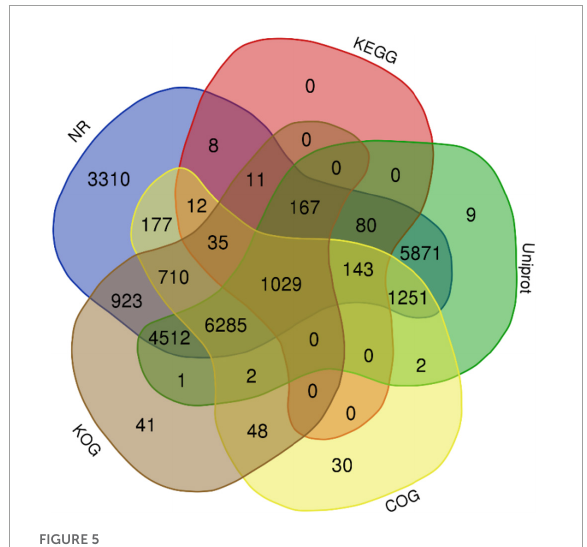
FIGURE5 Functional annotation of the predicted genes from ‘Bhagawa’ genome by using NCBI, NR, Kyoto Encyclopedia of Genes and Genomes, Uniport, Gene Ontology, Cluster of Orthologous Groups, and Eukaryotic Orthologous Groups